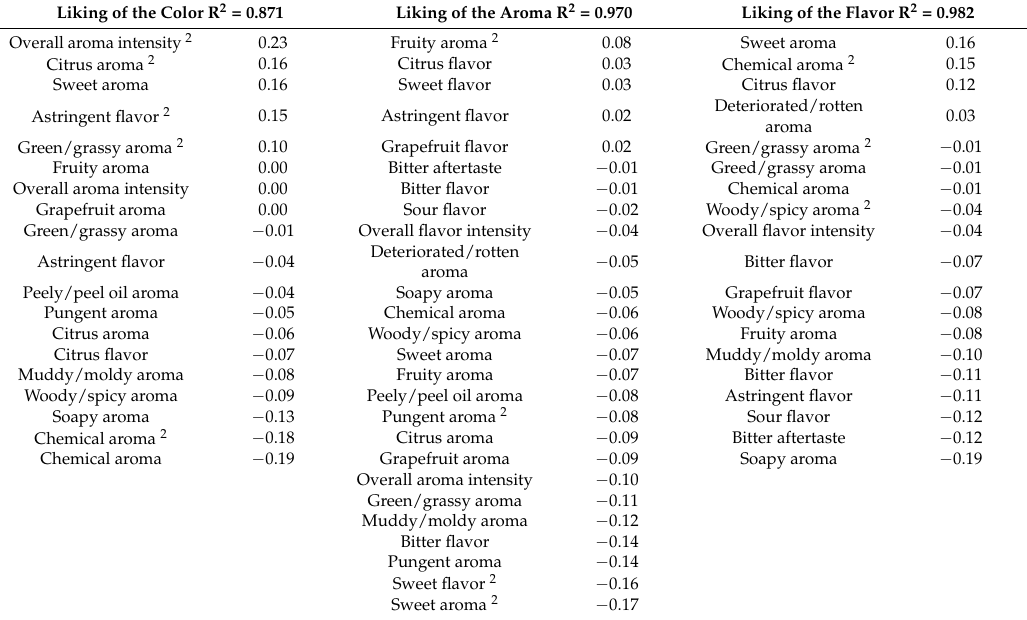
Table 5. Standardized partial least squares (PLS) regression coefficients for factors to summarize the relationship between predictors (X, consumer liking variables) and Y, sensory response variables. Only selected important variables (main effects and squared effects, noted as ‘ 2 ’) from the refined models are shown.